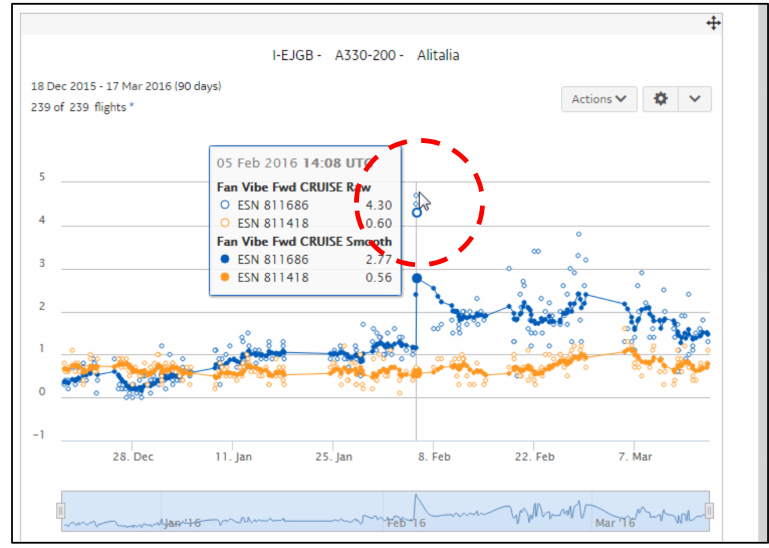
Figure 5. Alert for high fan